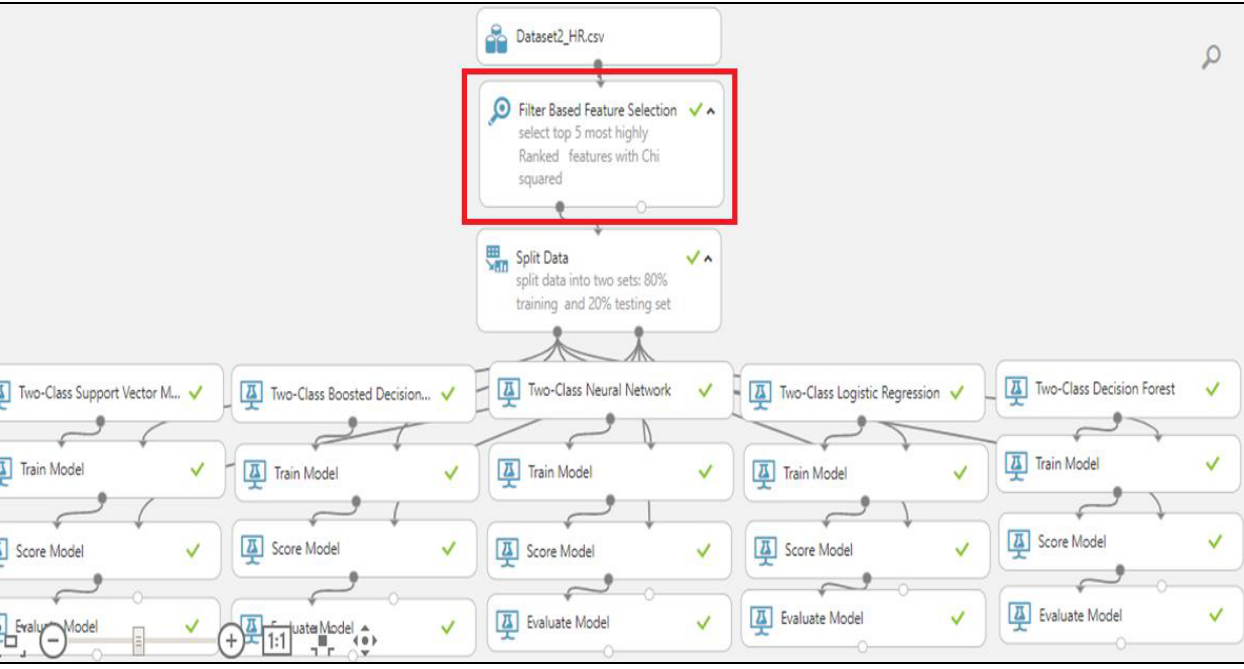
Figure 2. Workflow model of filter-based feature selection and classification.